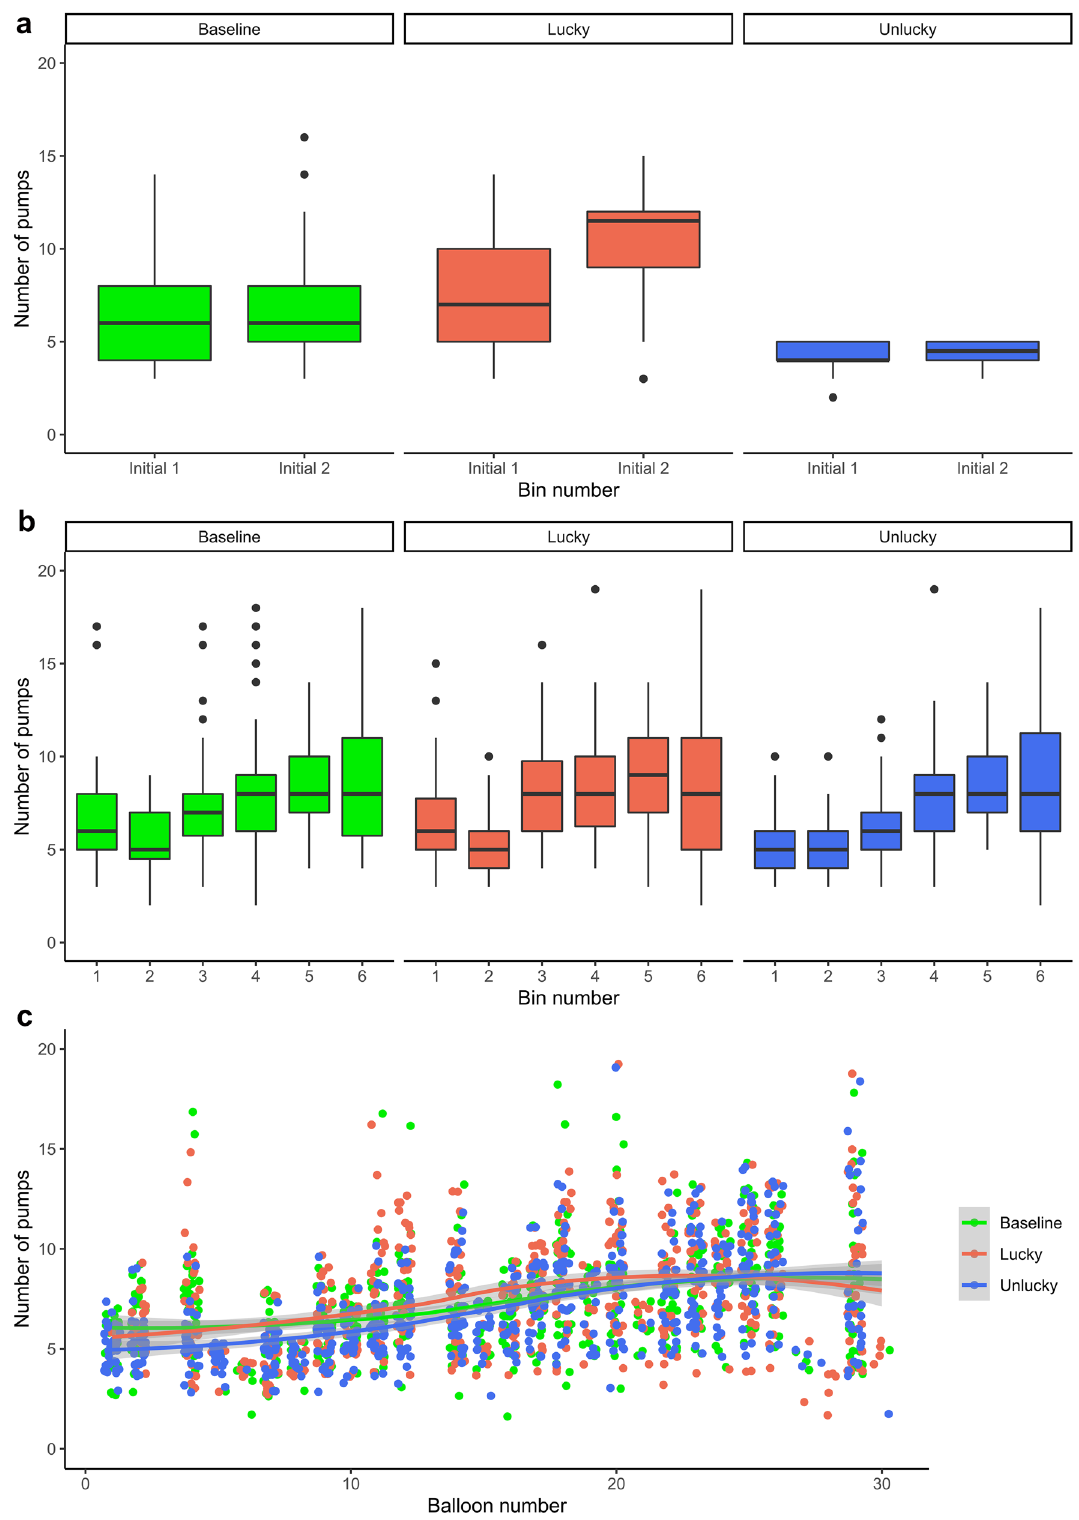
Figure 2. Results of Experiment 2. The numbers of pumps on balloons that did not burst are presented separately for each condition (baseline, lucky, unlucky) in each time bin of the initial ( a ) and subsequent ( b ) phases of the task. These phases were separated by a short pause lasting for a few seconds. Each time bin consists of five consecutive balloons. Figure part ( c ) shows the numbers of pumps on balloons that did not burst across all conditions and balloons. Shaded areas represent 95% confidence intervals for means, depicted with continuous lines. Points denote individual data points in all figure parts. Figures were created using the ggplot2 package 68